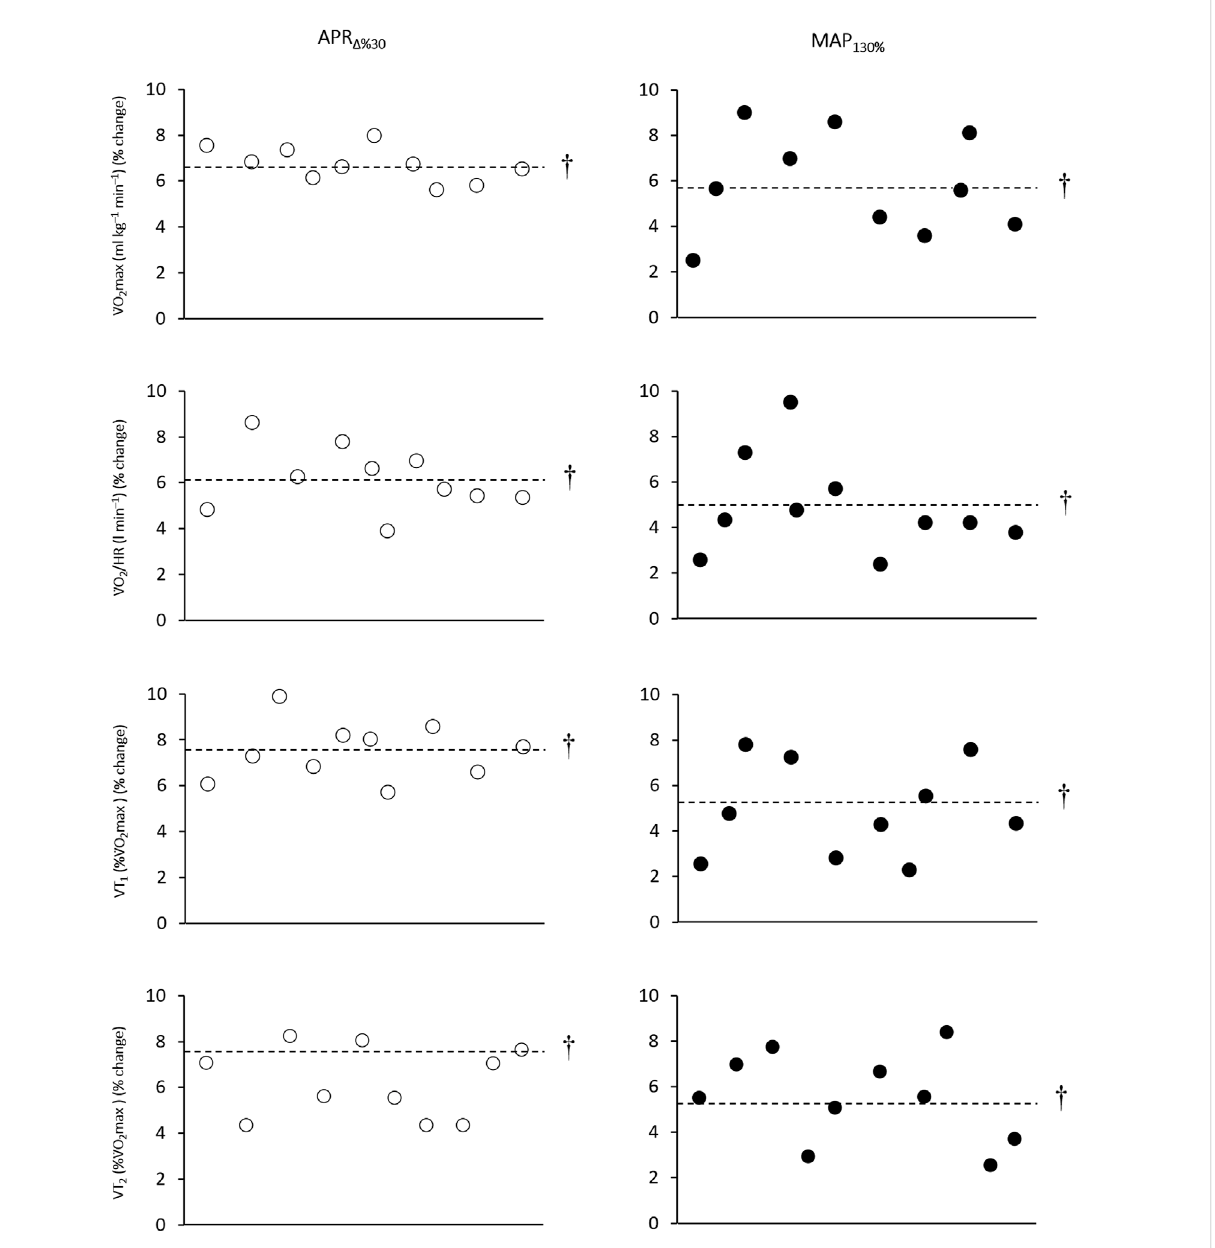
FIGURE 2 Effects of HIIT based on anaerobic power reserve (APR Δ %30 ) and maximal aerobic power (MAP 130% ) on V _ O 2 max, V _ O 2 /HR, VT 1 , and VT 2 . Circles indicate individual percent change from baseline and the dashed line represents the mean change of participants over time. † Denotes Signi fi cantly different versus pre-training ( p ≤